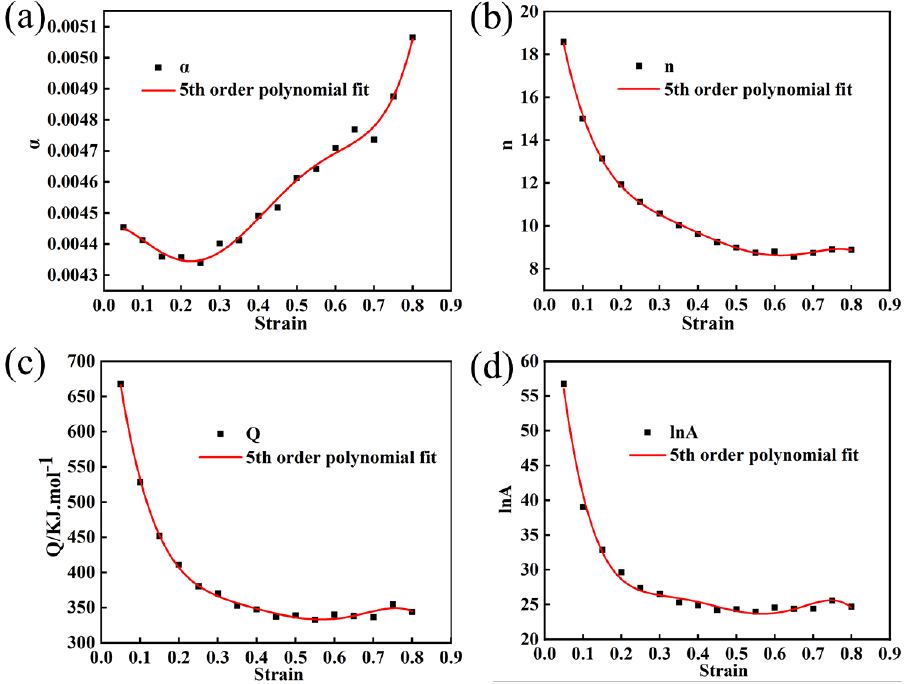
Figure 10. Material constants relationship between the strain of Mo–1.5wt% ZrO 2 : ( a ) α , ( b ) n , ( c ) Q , ( d ) ln A .